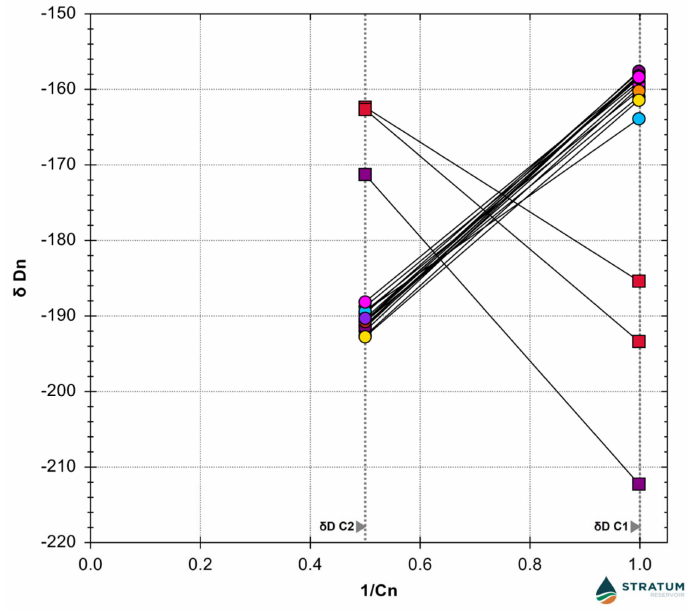
Figure 8. Natural gas plot of hydrogen isotope ratios for wet (squares) and dry (circles) Marcellus Formation produced natural gases in the Appalachian basin (after Chung et al. [39]).